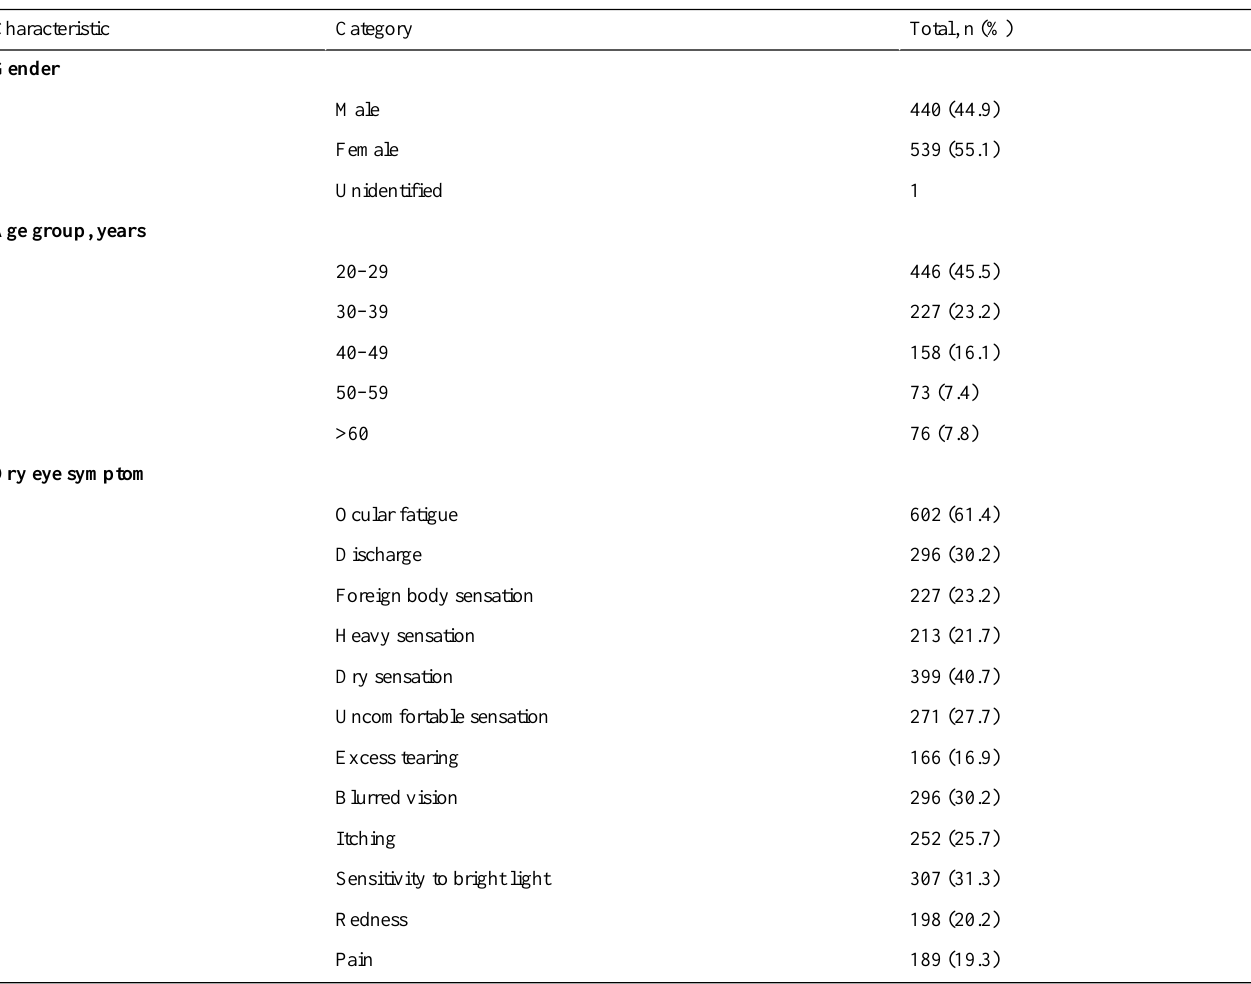
Table 1. Characteristics of the 980 first-phase